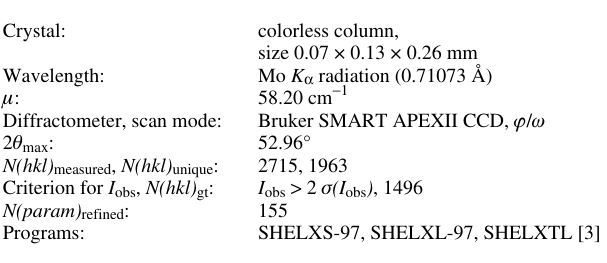
Table 1. Data collection and handling.